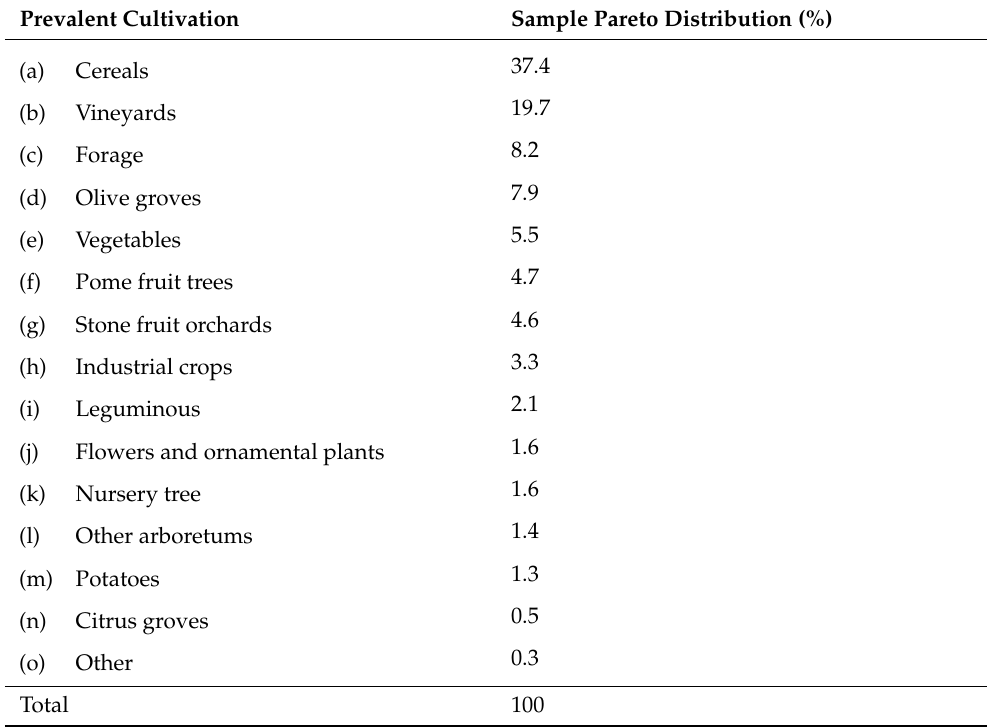
Table 6. Pareto distribution of prevalent cultivation.